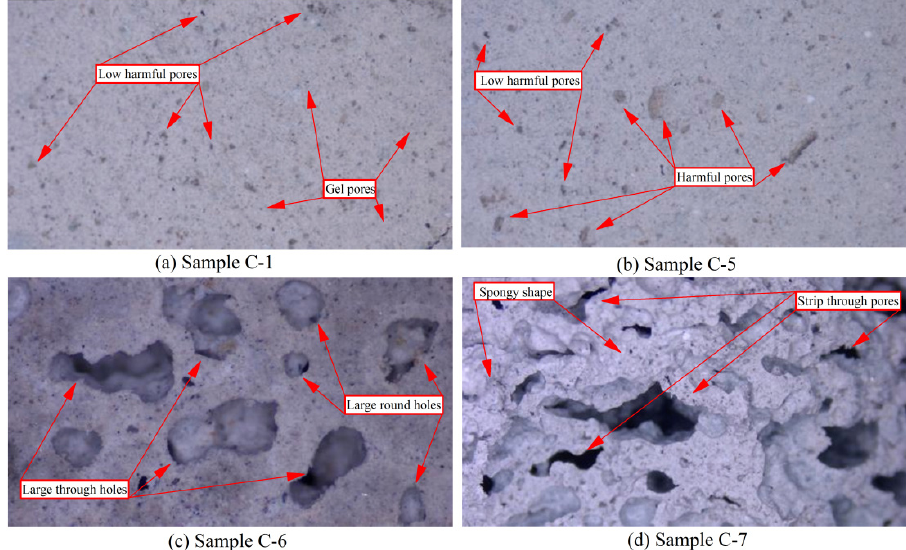
Figure 4. Low SEM analysis of samples C-1, C-5, C-6, and C-7 (magnification ×100).